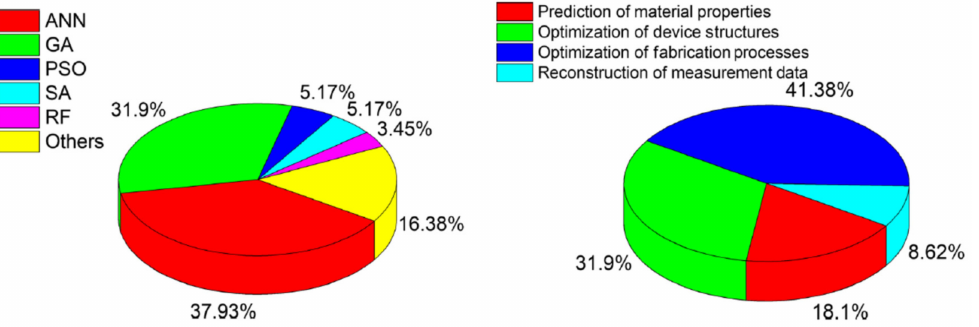
Figure 2. Left: Distribution of types of ML techniques applied in design and fabrication of solar cells. Right: Distribution of applications in design and fabrication of solar cells assisted by ML techniques. Adapted with permission from [15]. Copyright 2019 Wiley-VCH Verlag